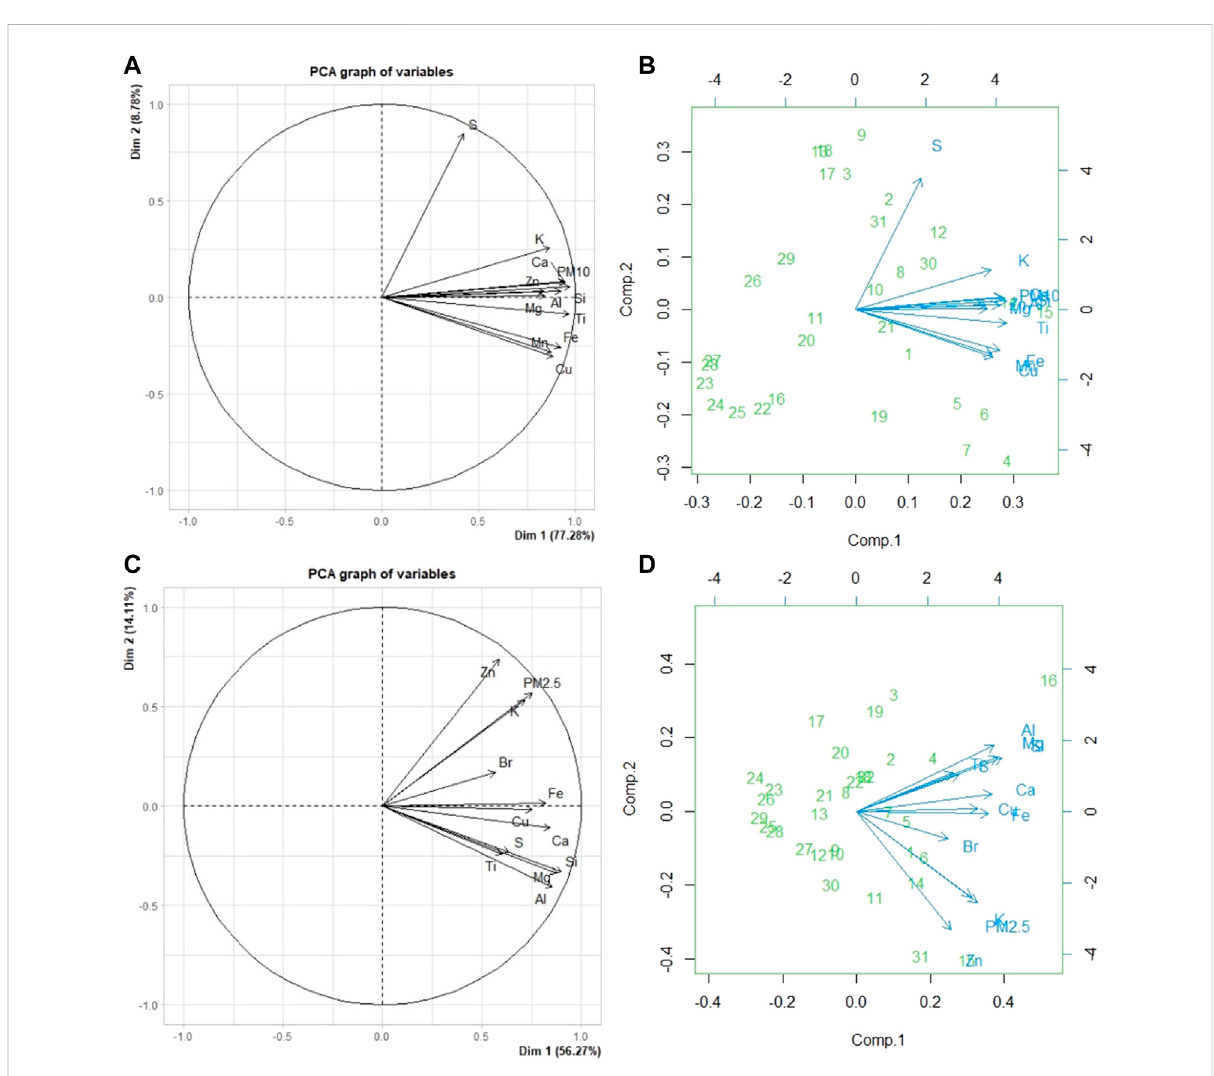
FIGURE 10 Plot component weights: PM10 (A) ; PM2.5 (C) . Biplot: PM10 (B) ; PM2.5 (D) obtained by PCA